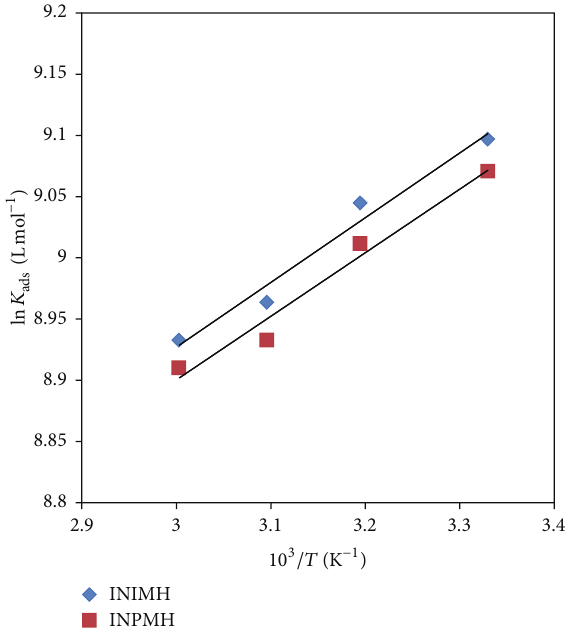
Figure 5: ln 𝐾 versus 1/𝑇 plots of INIMH and ads